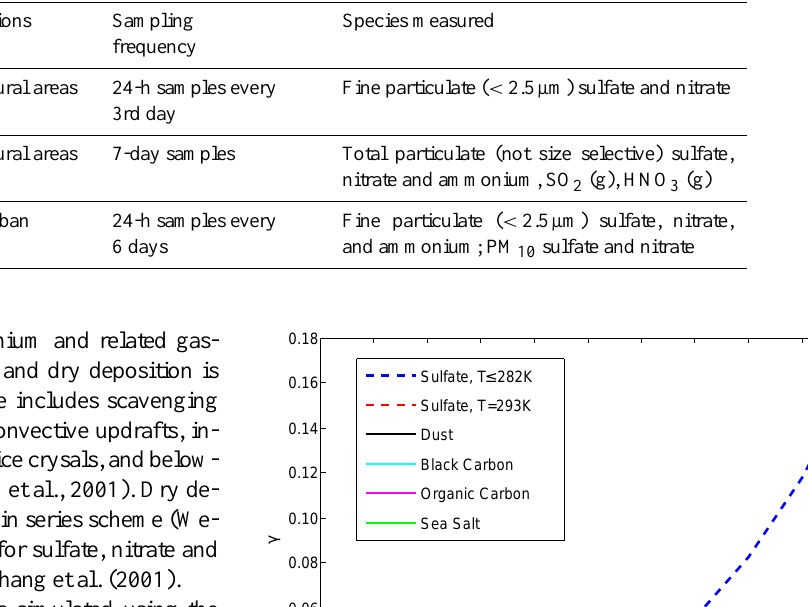
Table 1. Measurement datasets.